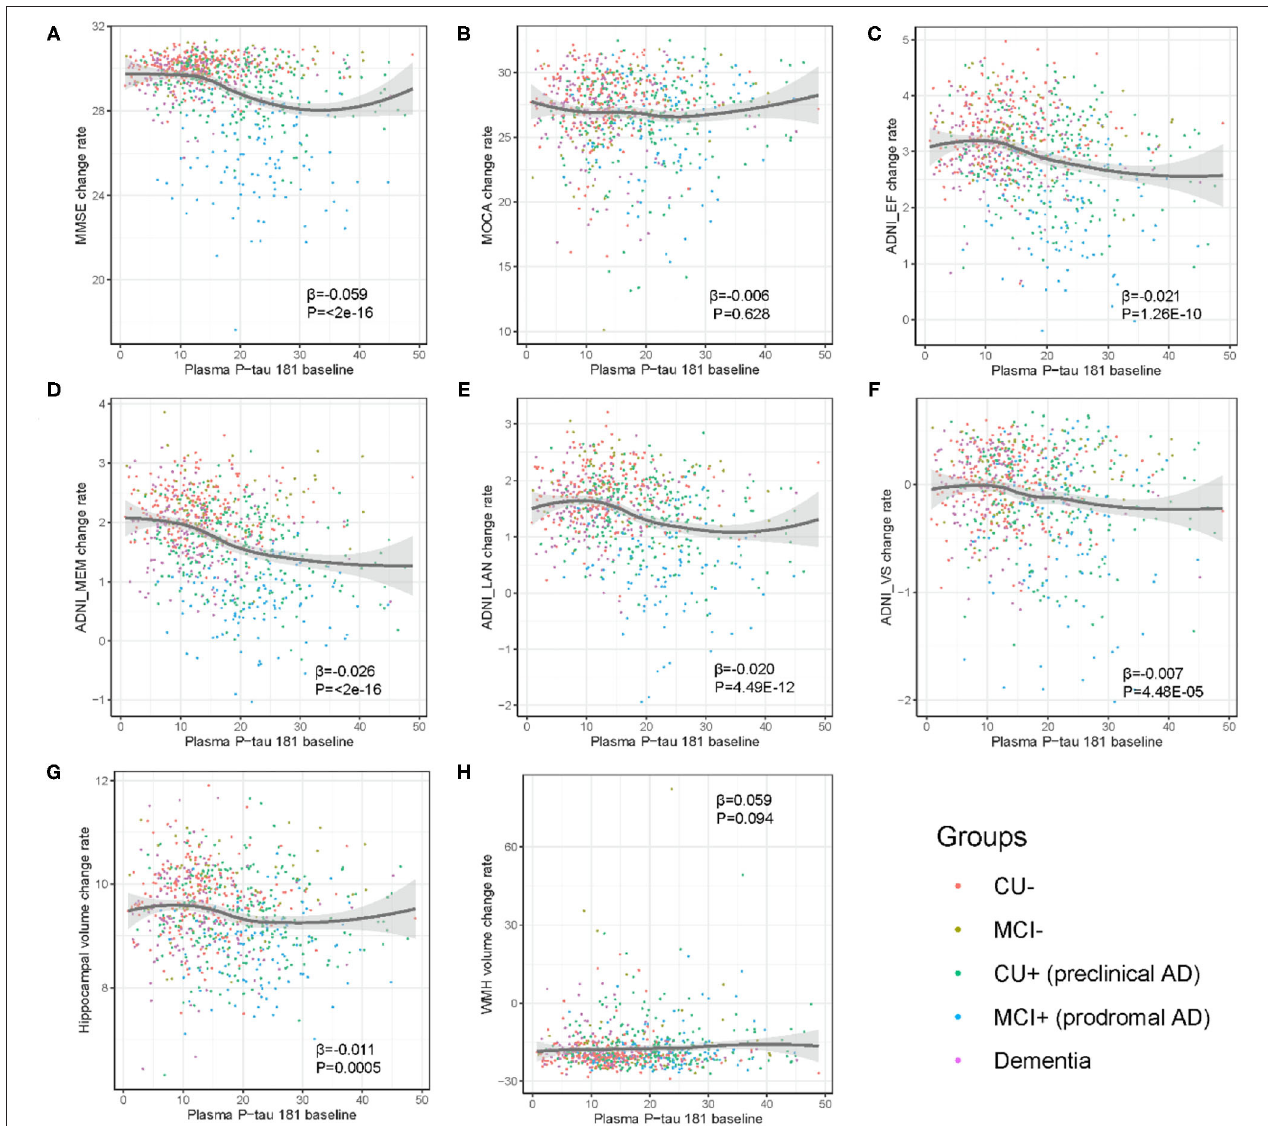
FIGURE 4 | (A–H) Association of baseline level of plasma p-tau181 with yearly change of cognition and neuroimaging biomarkers. The rate of change in biomarkers was calculated in linear mixed effects model, adjusted for age, sex, education, and APOE genotype. CU–, cognitively unimpaired with negative A β ; MCI–, mild cognitive impairment with negative A β ; CU + , cognitively unimpaired with positive A β ; MCI + , mild cognitive impairment with positive A β